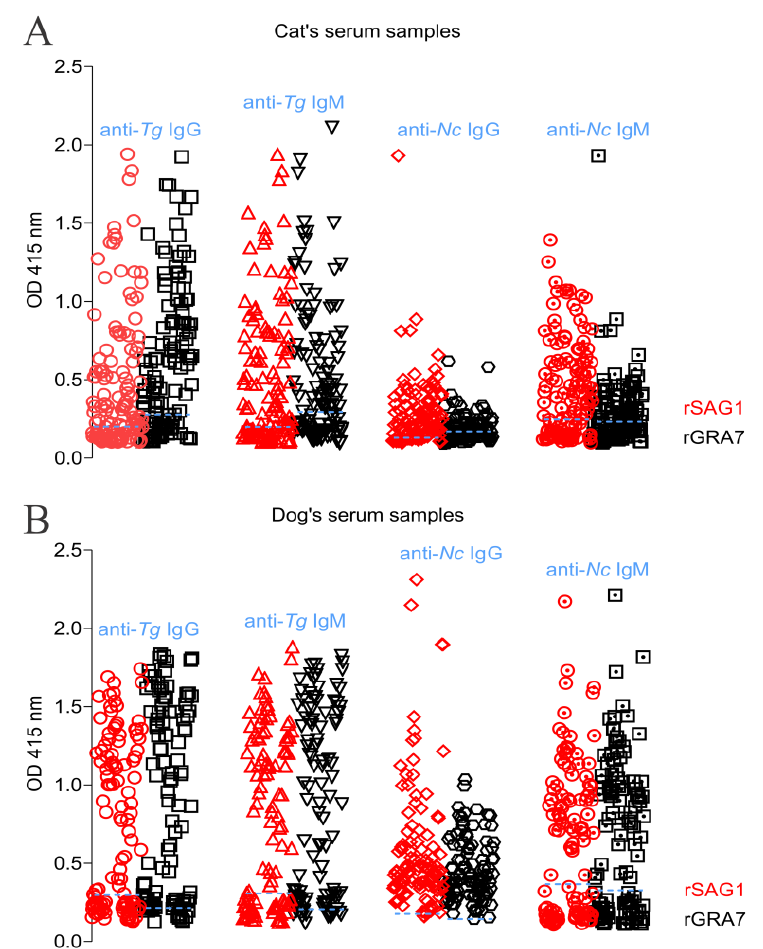
Figure 1. Serological detection of T. gondii and N. caninum infection in stray cats and dogs in the QTPA. ( A ) The T. gondii- and N. caninum -specific IgG and IgM antibodies in stray cats using the indirect ELISA based on rTg / Nc SAG1 and GRA7. ( B ) The T. gondii and N. caninum specific-IgG and IgM antibodies in stray dogs using the indirect ELISA based on rTg / Nc SAG1 and GRA7.